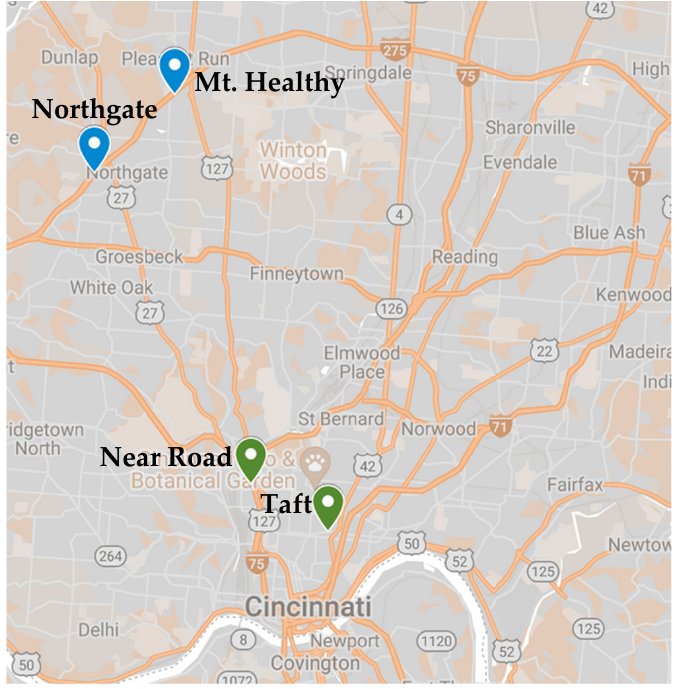
Figure 1. Map of air quality (green) and traffic (blue) monitoring sites used in this study (Google Maps, [26]).